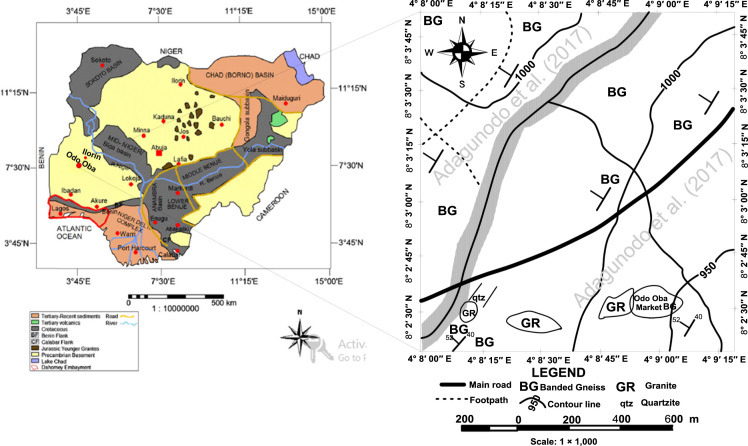
Geology and location of Odo-Oba (modified after [3]).